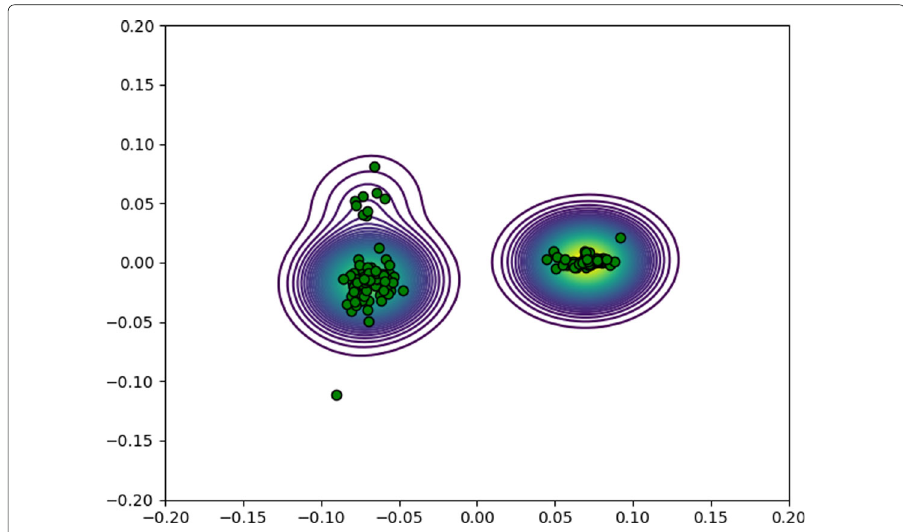
Fig. 1 2-D spectral plot of graph nodes. The graph nodes are plotted as points, the contours show the magnitude of the density function, and the horizontal and vertical axes correspond to the ξ ( 2 ) and ξ ( 3 ) components, respectively. This particular plot shows two distinct communities with one node at approximately (-0.09,-0.11) that does not belong very strongly to either community and a cluster of points around (-0.07,0.05) that seems close to forming its own